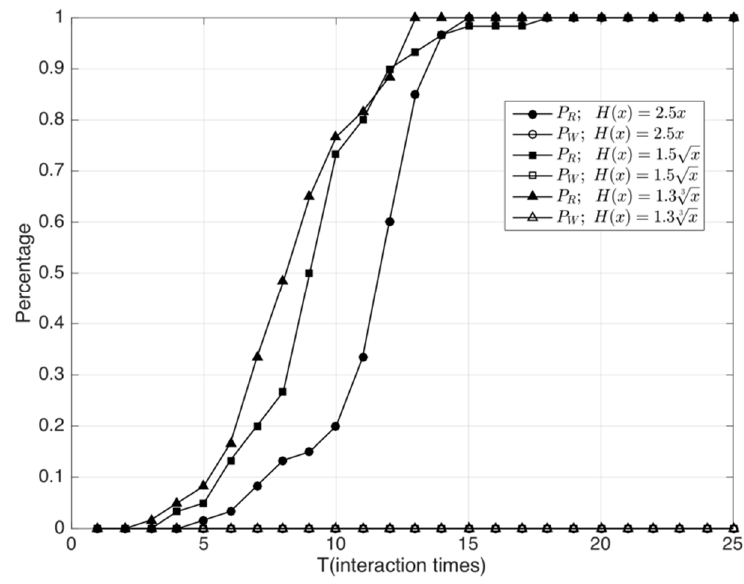
Figure 4. Performance evaluation and comparison of different H(x) functions.